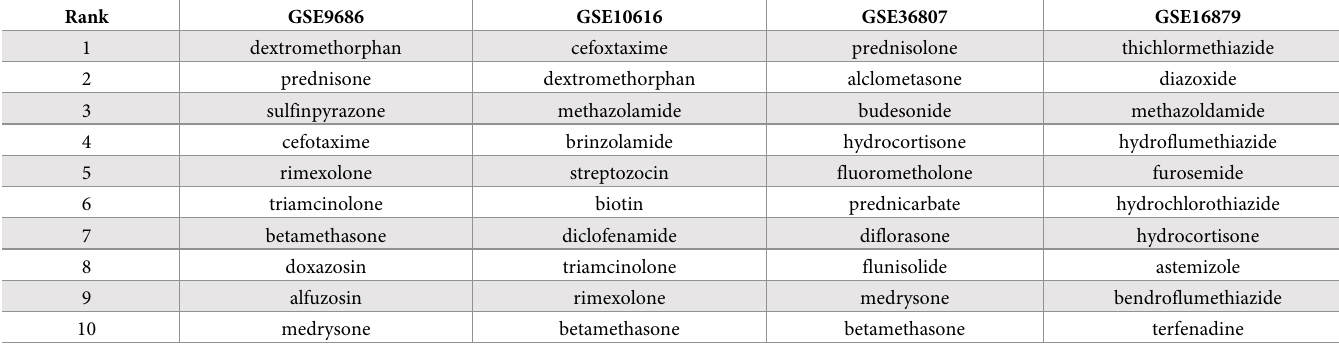
Table 2. Average drug rankings for each GEO study for UC